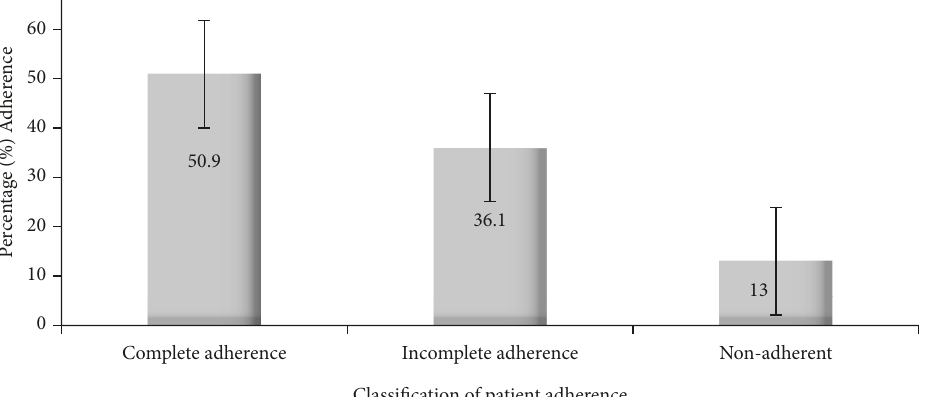
Figure 1: Classification of patient adherence to dihydroartemisinin-piperaquine treatment for uncomplicated malaria. Complete adherence, incomplete adherence, and nonadherence of enrolled patients to dihydroartemisinin-piperaquine.